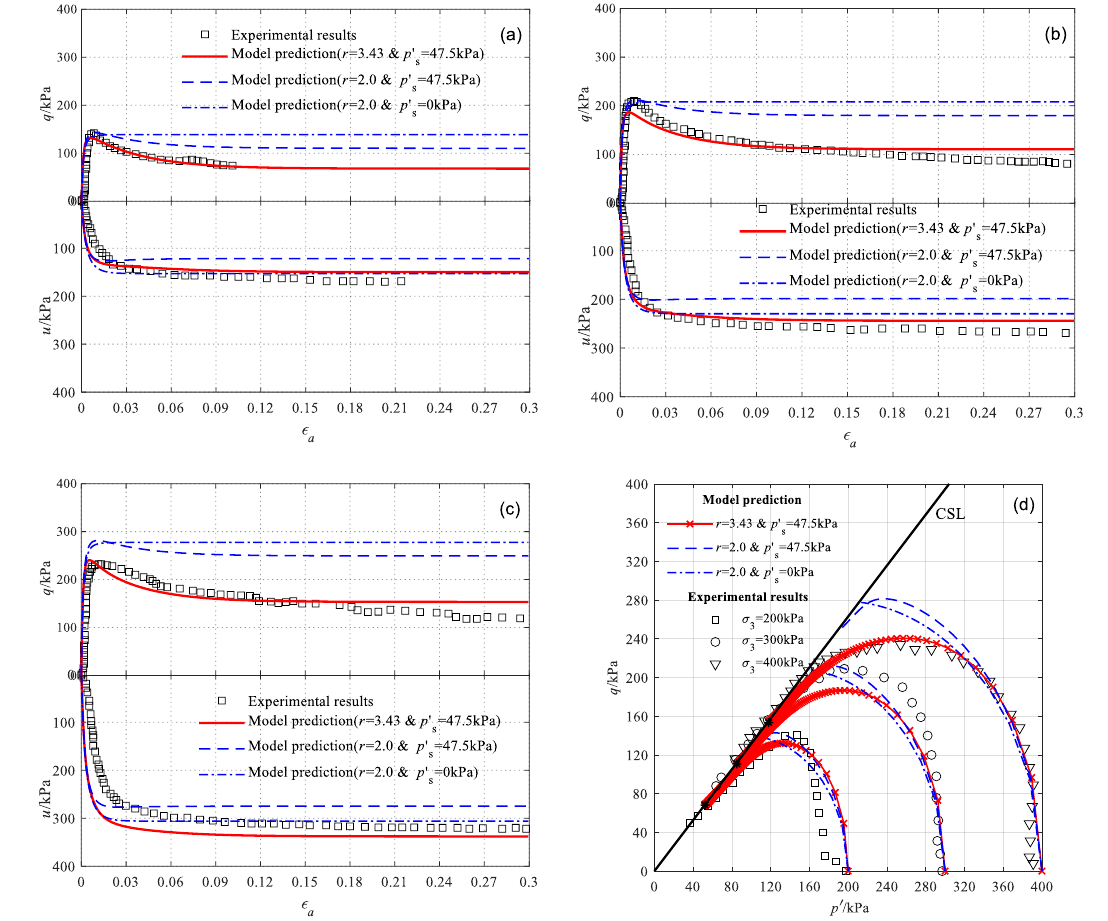
Figure 11. Comparisons between model prediction and test results: ( a ) stress-strain and pore pressure σ ’ 3 = 200 kPa, ( b ) stress-strain and pore pressure σ ’ 3 = 300 kPa, ( c ) stress-strain and pore pressure σ ’ 3 = 400 kPa, ( d ) stress